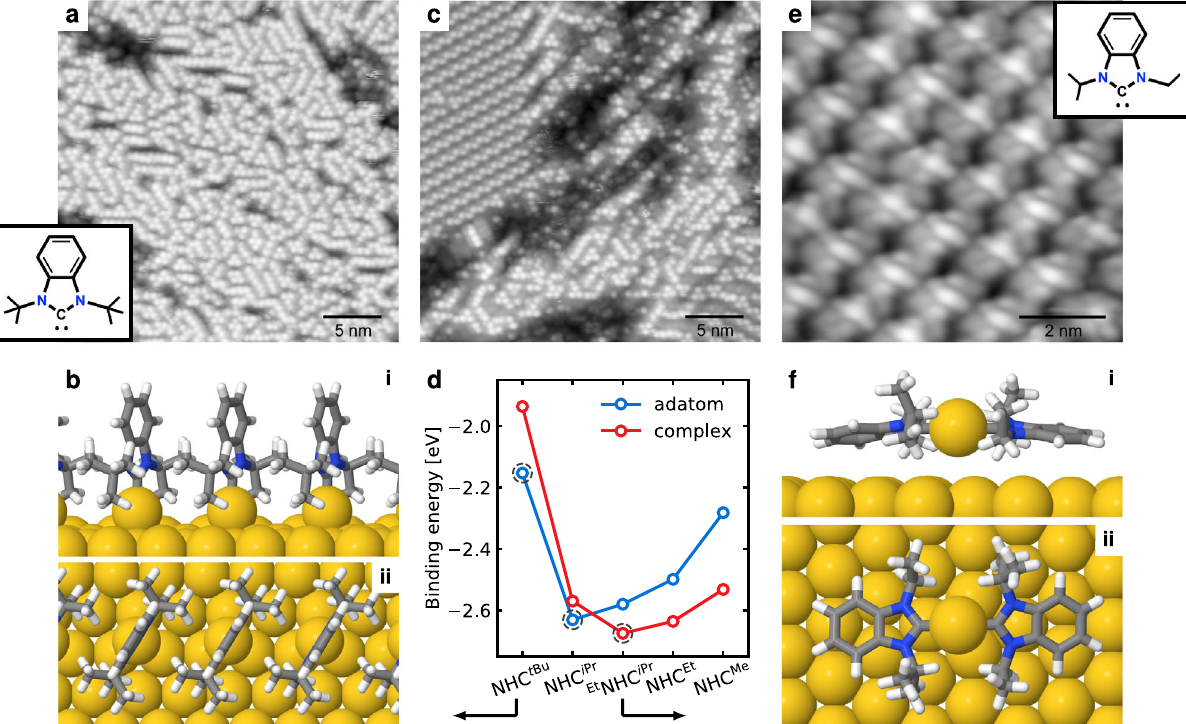
Fig. 3 In fl uence of the wingtip groups on NHC binding and self-assembly. a NHC tBu self-assembles into short closely packed lines on Au(111) at saturation coverage (20pA, 100mV, 30.0×30.0nm 2 ). b Side and top views of NHC tBu in a linear arrangement showing the adatom attachment geometry. c Phase- separation of NHC iPr and NHC tBu molecules co-deposited in equal amounts on Au(111) (20pA, 600mV, 30.0×30.0nm 2 ). d Binding energy per NHC for NHC- adatom and bis-NHC complex con fi gurations for several benzimidazole-based NHCs. e Et NHC iPr forms fl at-lying (NHC) 2 Au complexes when deposited onto Au(111) at room temperature (30pA, 400mV, 8.0×8.0nm 2 ). f Side and top views of the (NHC) 2 Au complex centered above a threefold hollow